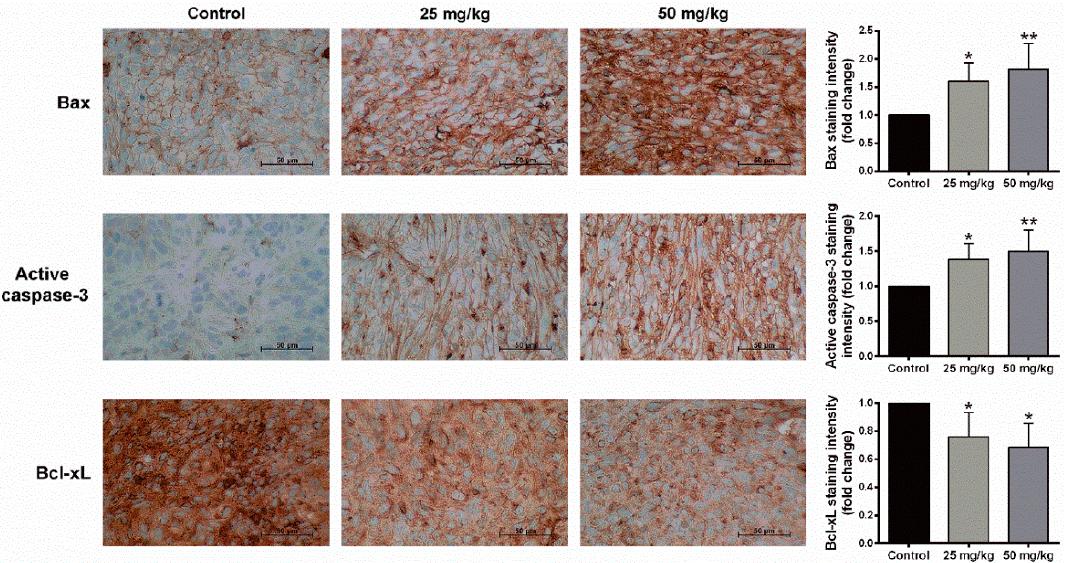
Figure 7. BJA-95 inhibited CCA growth by targeting apoptosis. Representative photos of the immunohistochemistry of Bax, active caspase-3 and Bcl-xL at a magnification of × 400. Bar graphs illustrate the levels of protein expression. Results are shown as mean ± SD ( n = 5). (*) p < 0.05 and (**) p < 0.01 when compared to the control group.